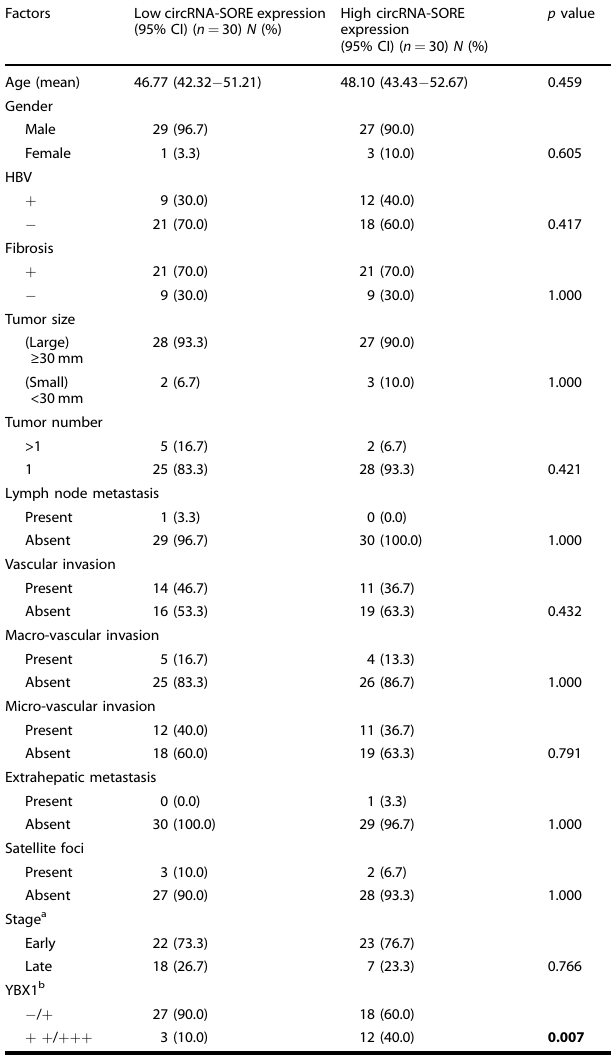
Table 1. CircRNA-SORE expression and clinicopathological factors in HCC